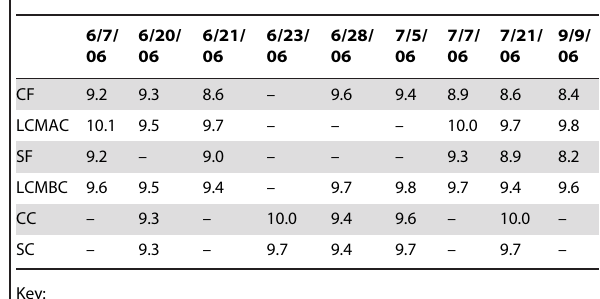
Table 3. Dissolved Oxygen